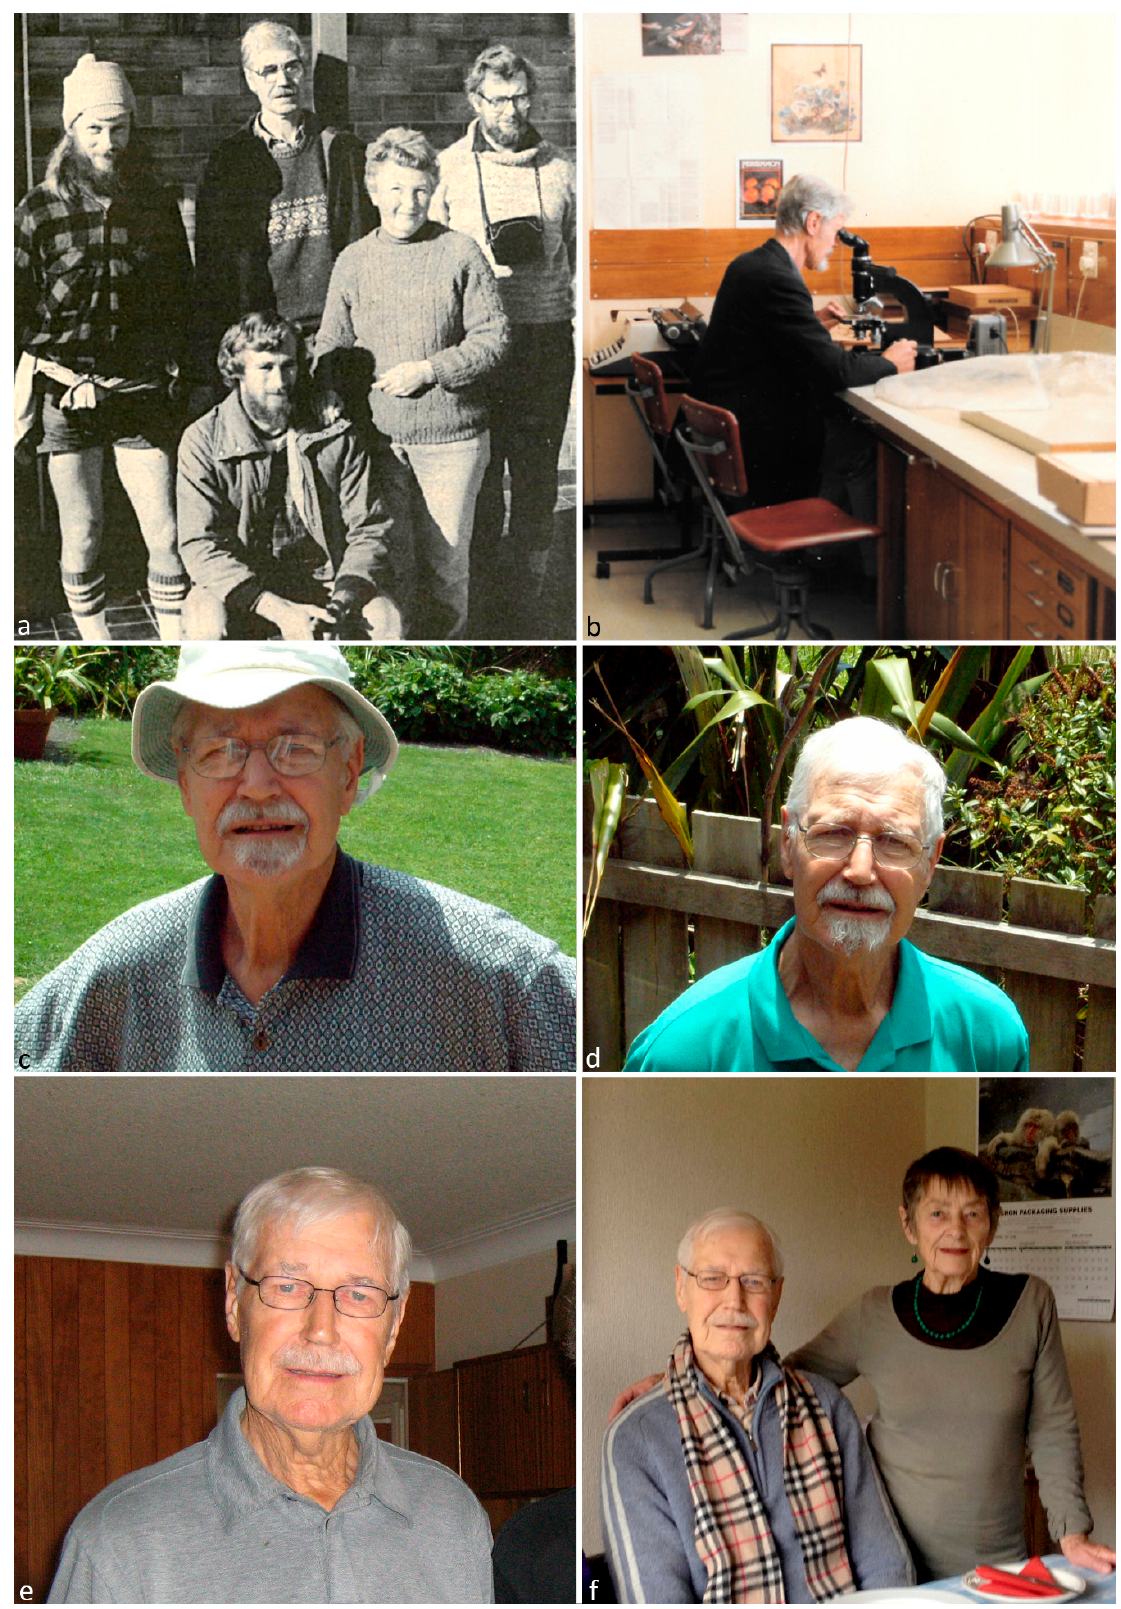
Figure 3. Willy Kuschel in later years: ( a ) with the beetle hunting team of the Waitomo Caves, New Zealand, May 1983 (f.l.t.r. Trevor Crosby, Charles Watt, Willy Kuschel, Brenda May, Trevor Worthy) (© Waitomo News); ( b ) working in his office, 1985 (photo: CHCL); ( c ) in his garden, January 2013; ( d ) in his garden, February 2013; ( e ) at home in Auckland, January 2011 (photo: SDJB); ( f ) at dinner at home with Beverley, September 2013.